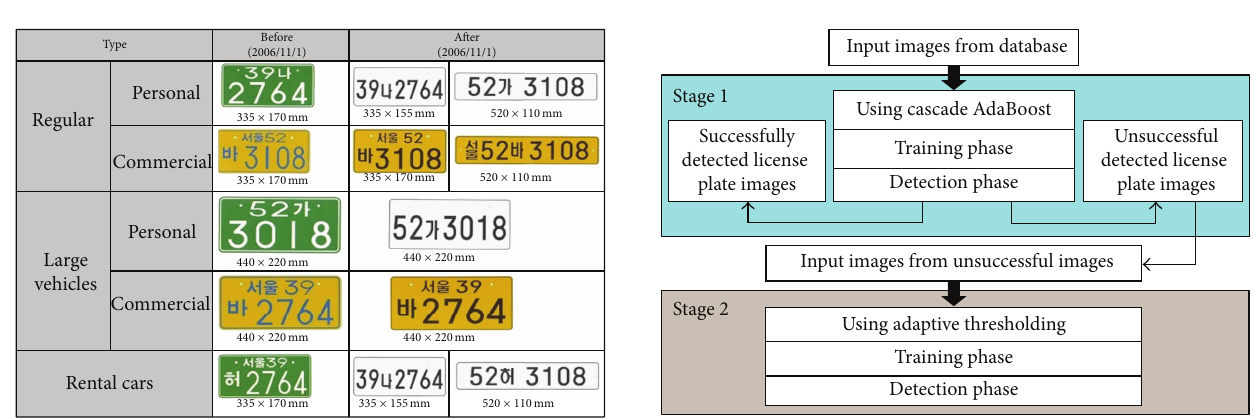
Figure 1: Different types and sizes of Korean LPs. Figure 2: System architecture of the proposed LPD system using cascade AdaBoost.